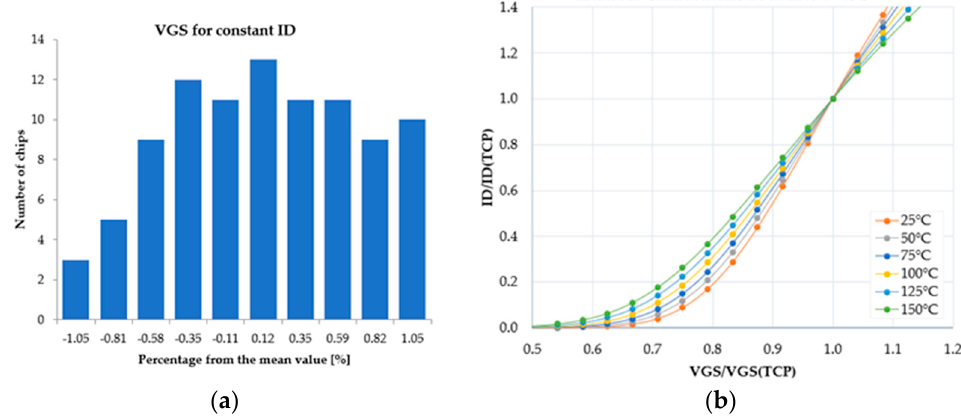
Figure 9. ( a ) Gate-to-source voltage spread for constant I D ; ( b ) Normed transfer characteristic of the DMOS transistor